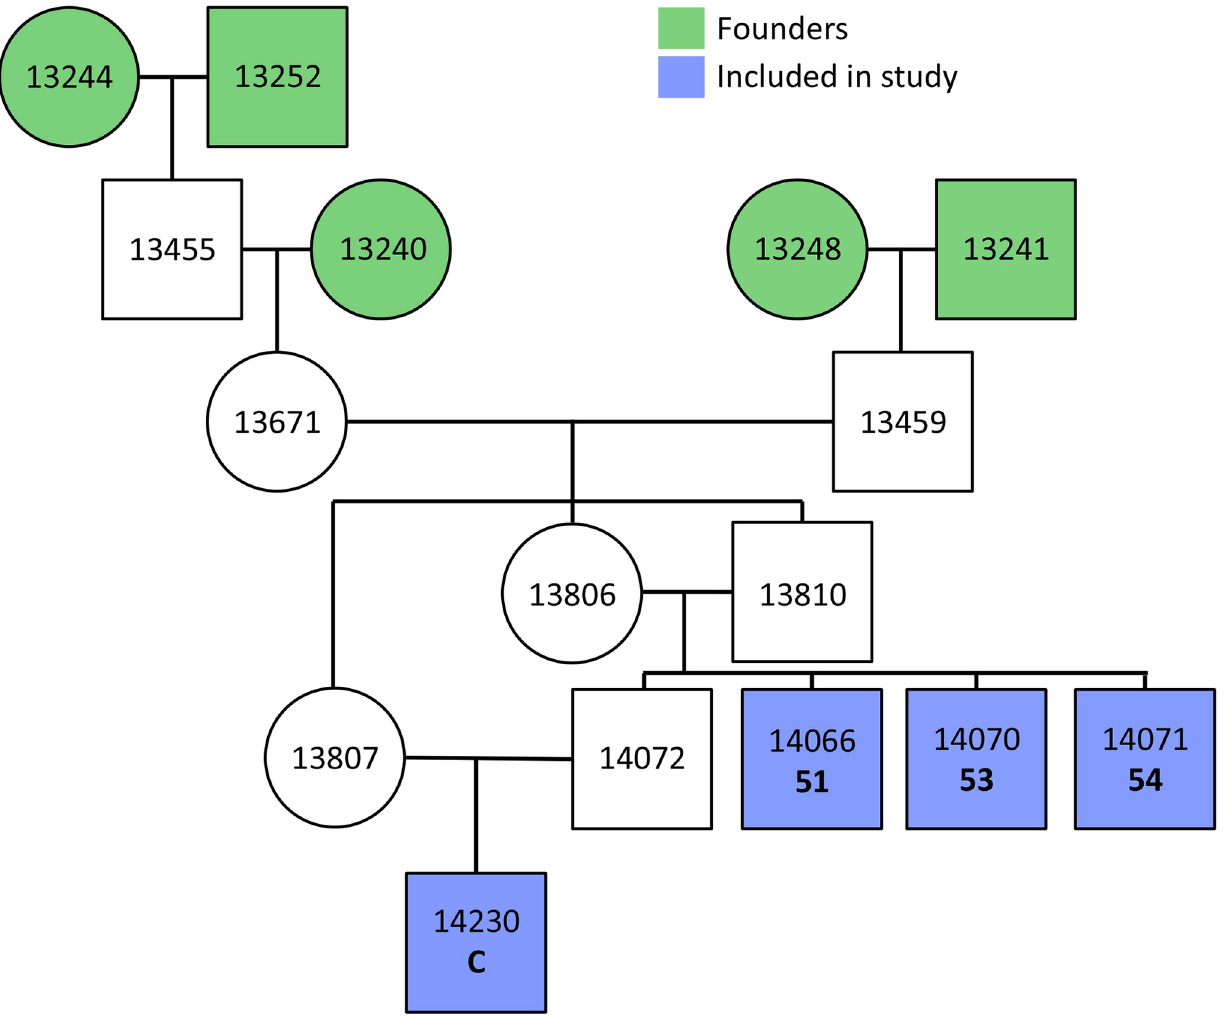
Fig 1. Family pedigree displaying relatedness of individuals used in this study. Wild individuals collected from Mongolia (founders) are shown in green. The four male pikas used in this study are shown in blue. Circles indicate females and squares indicate males. The inbreeding coefficient for individuals 51, 53, and 54 is 0.25. The inbreeding coefficient for individual C is